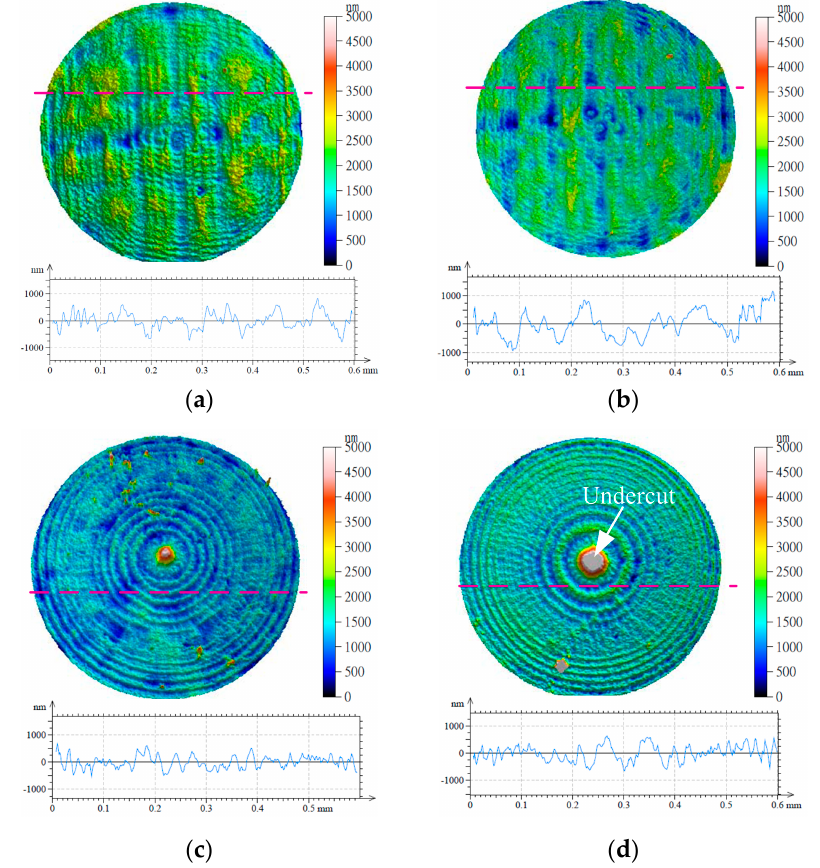
Figure 6. Surface morphology and outline of micro-molds with different machining strategies ( n = 10,000 r/min, f = 45 mm/min, L w = 0.02 mm). ( a ) Single-direction raster; ( b ) raster; ( c ) 3D offset spiral; and ( d ) equal height finish.